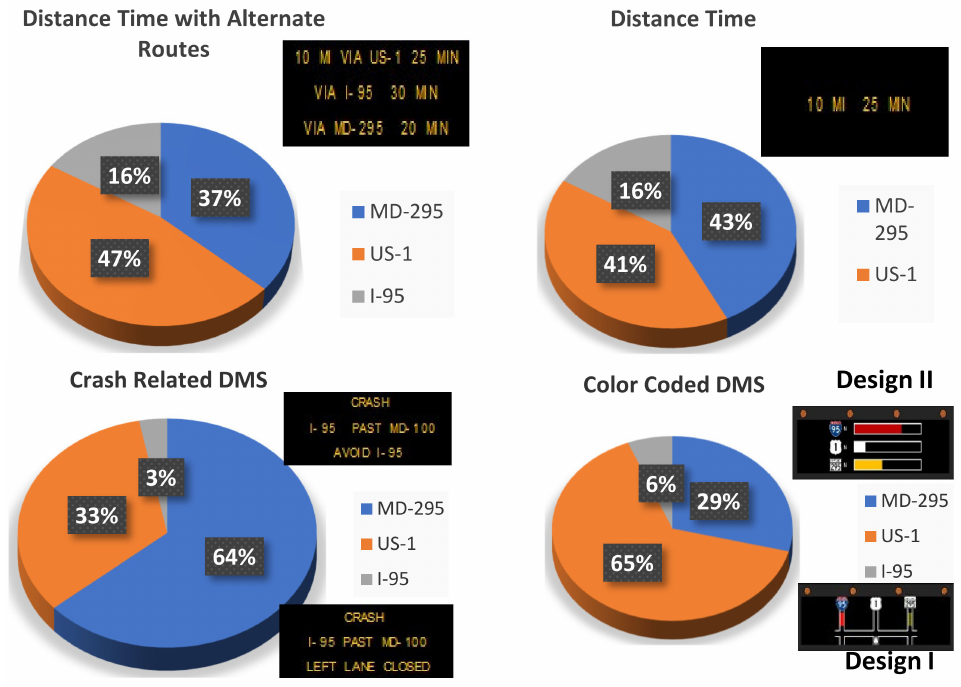
Figure 6. Revealed route choice